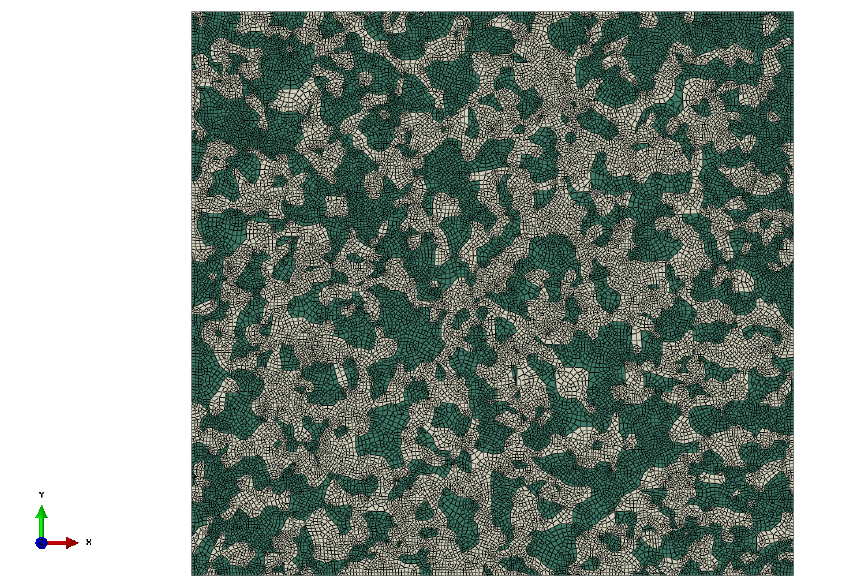
Figure 6. Schematic illustration of mesh and morphology used in FEM for